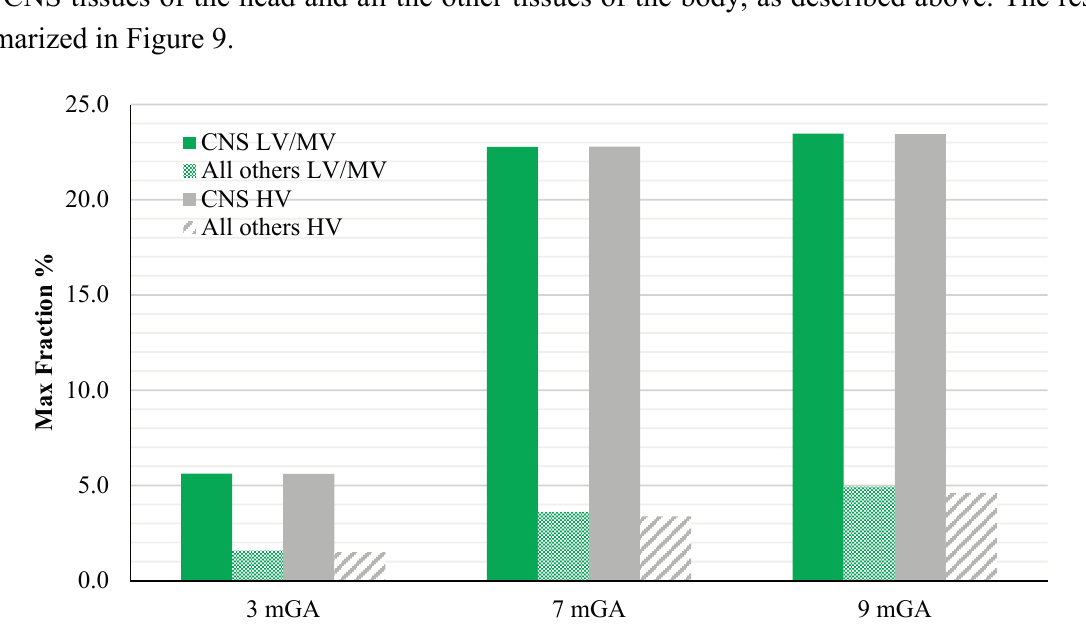
Figure 9. Maximum fraction of the ICNIRP Basic Restrictions for general public on the E 99th for the CNS and all other tissues, exposed to a magnetic field at the reference level using the standard EN 50160 (B levels shown in Table 4), at different